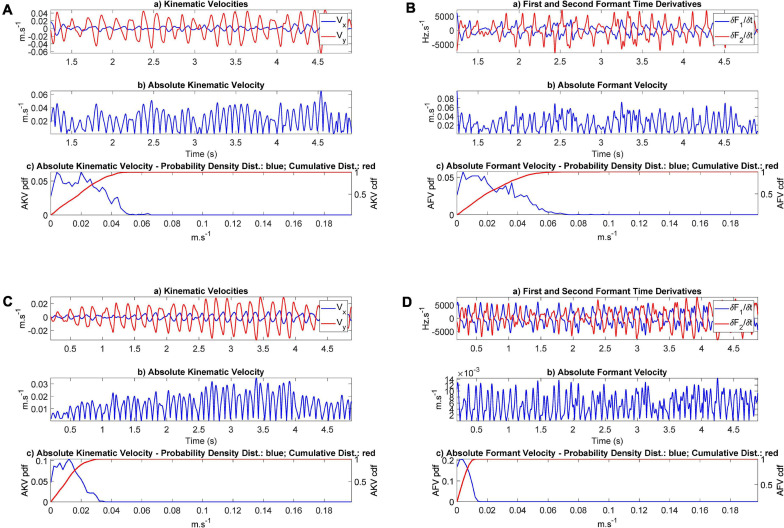
Absolute Kinematic and Formant Velocities (AKV and AFV): (A) AKV from participant CMa; (B) AFV from participant CMa; (C) AKV from participant PMa; (D) AFV from the PD participant PMa. In each plot the subplot (a) represents the horizontal and vertical velocities or the corresponding formant derivatives in the time domain. The subplot (b) represents the instantaneous value of the absolute velocity. The subplot (c) gives the density distribution (in blue) and the accumulated distribution (in red). The range of the common scale of velocities goes from 0 to 20 cm.s− 1.